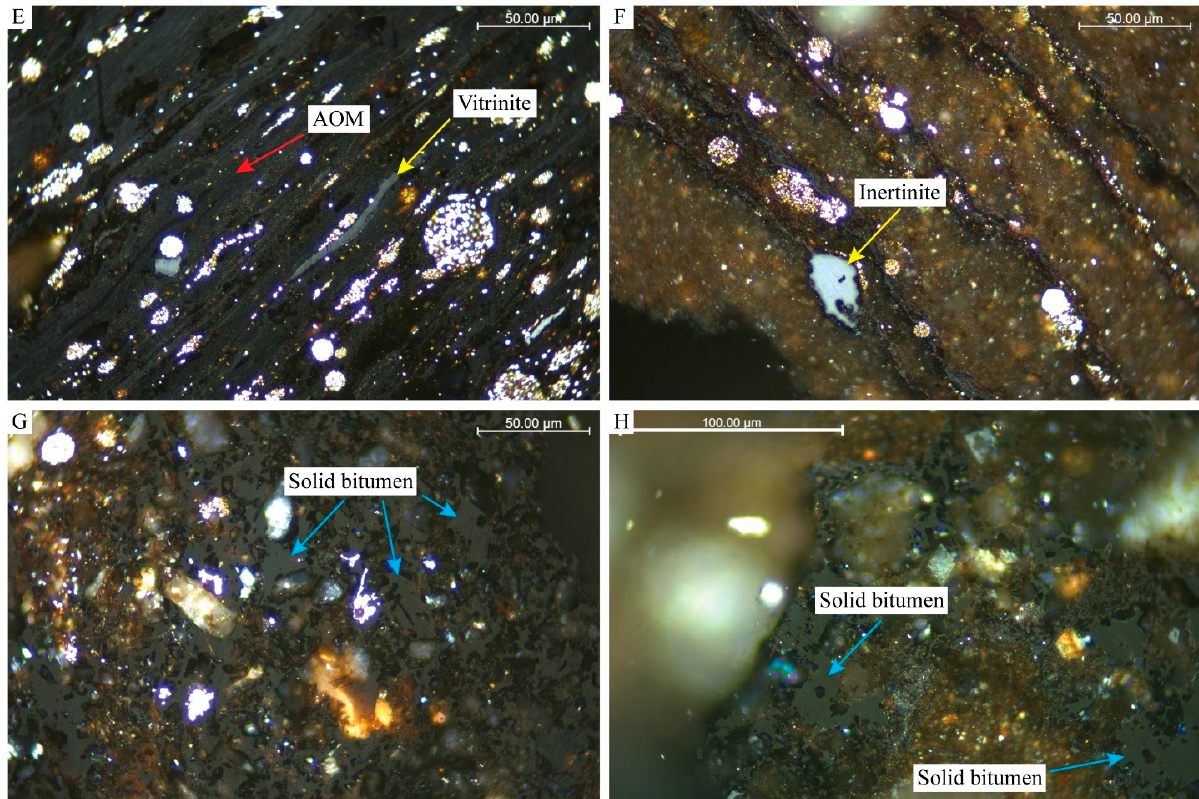
Figure 4. Photomicrographs of macerals in reflected white light and oil immersion ( A , B , E – H ) and in fluorescence mode ( C , D ) in the studied Chang 7 Member shale samples. ( A , B ) Amorphous organic matter (AOM). Note that AOM is mixed with fine mineral particles, especially pyrite. ( A ) Sample KQ-4. ( B ) Sample KQ-5. ( C , D ) Alginite. ( C ) A Botryococcus in the center. Abundant greenish yellow fluorescing algal bodies parallel to bedding. Sample KQ-2. ( D ) Intercalated greenish yellow fluorescing alginite and very weak brownish fluorescing AOM. Sample KQ-5. Panel D is the same view as panel B in fluorescence mode. ( E ) Vitrinite and AOM. Sample KQ-6. ( F ) Inertinite. Sample KQ-1. ( G , H ) Solid bitumen occurring between mineral grains. ( G ) Sample KQ-6. ( H ) Sample KQ-4.